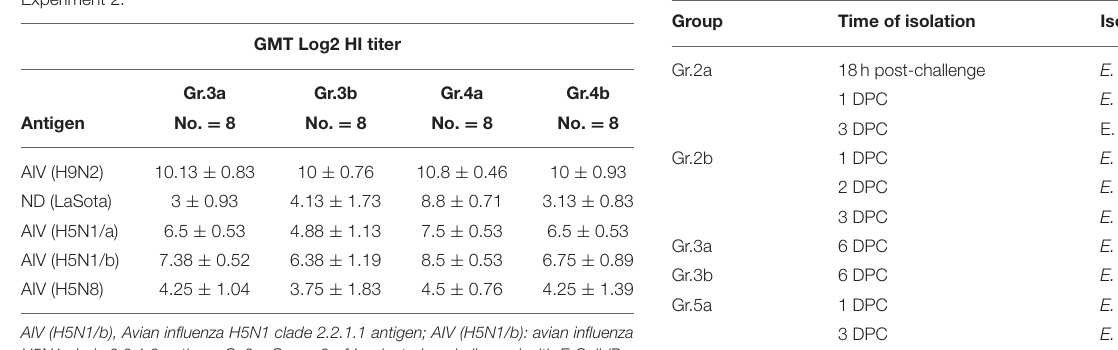
TABLE 7 | Bacterial isolation post-challenge,